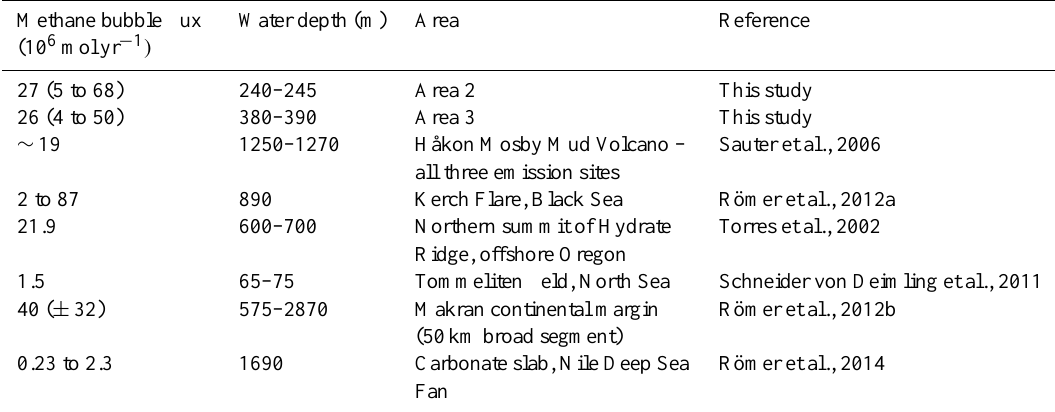
Table 6. Fluxes of bubble-forming methane from the seafloor to the hydrosphere in various regions.